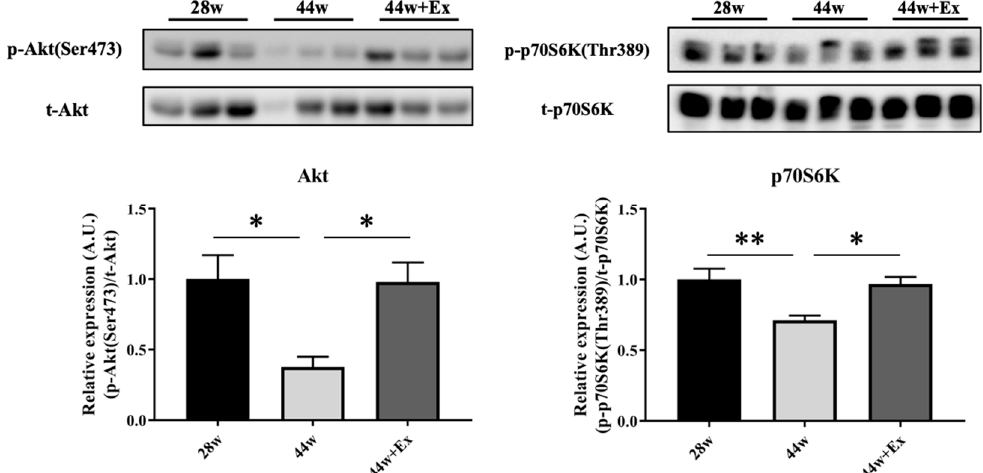
Figure 4. The phosphorylation level of Akt (Ser473) and p70S6K in gastrocnemius muscle. Total protein was extracted from gastrocnemius muscle and both proteins were analyzed by Western Blot analysis. Akt: Protein kinase B, p70S6K: 70-kDa ribosomal protein S6 kinase. 28 week old (28 w), 44 week old (44 w) and exercise (44 w + Ex). Values are means ± SE ( n = 6). Double asterisks indicate significant differences ( p < 0.01). Single asterisk indicates significant differences ( p <